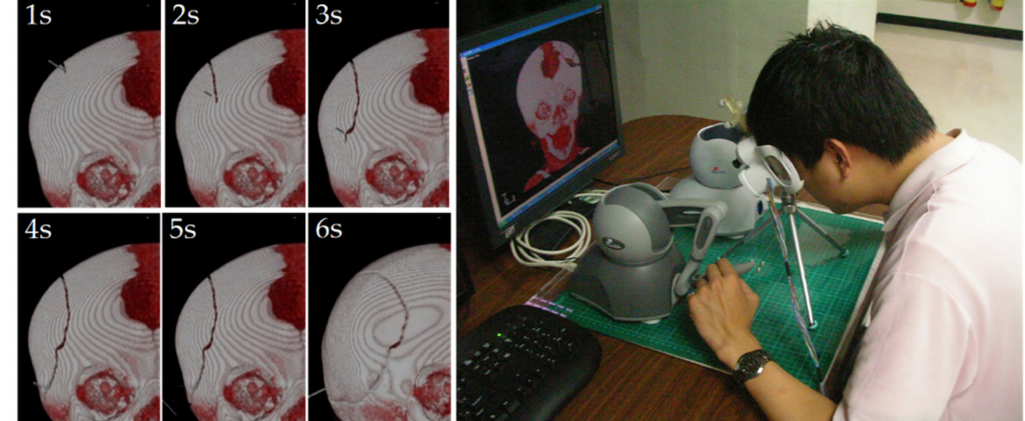
Figure 6. Simulation and integration test of experiment system. The time is 1–6 s from left to right, respectively.